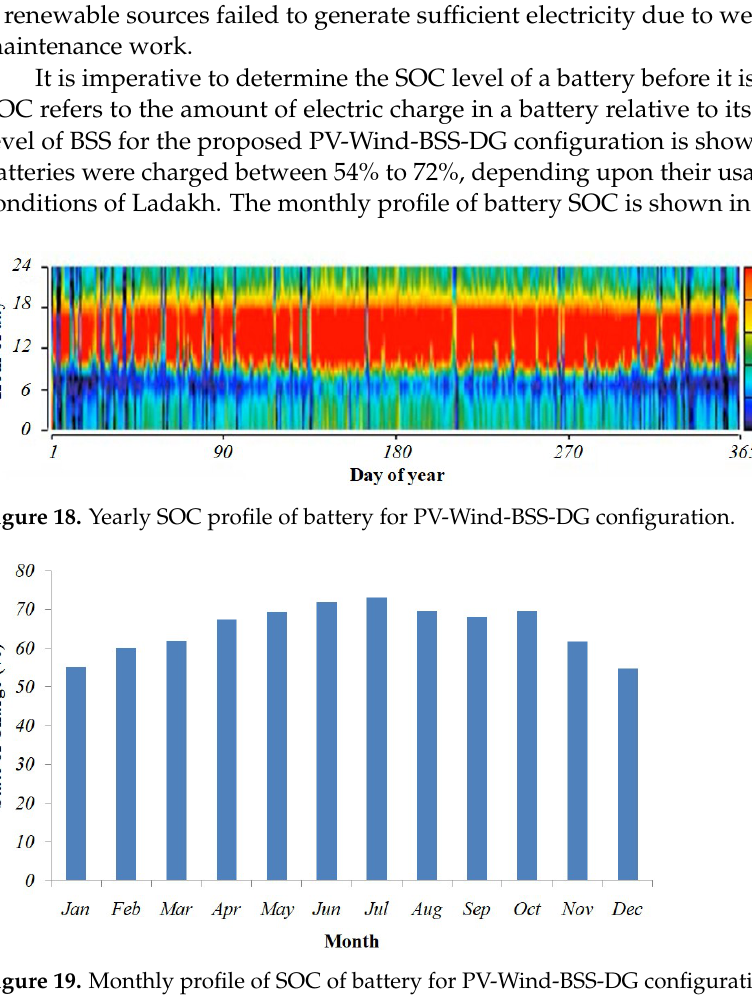
Figure 19. Monthly profile of SOC of battery for PV-Wind-BSS-DG configuration.